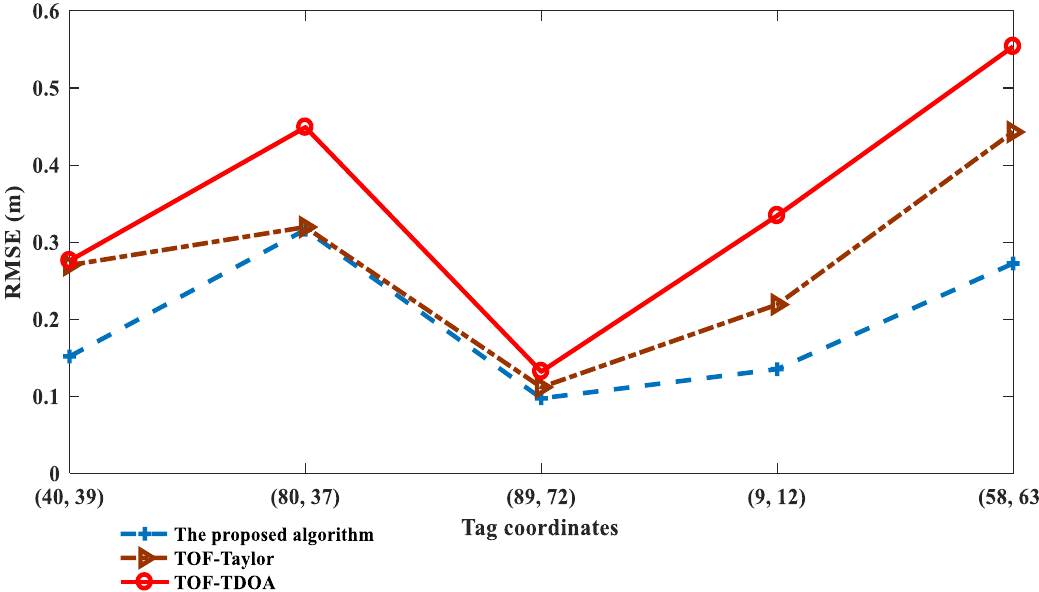
Figure 5. RMSE of the proposed positioning algorithm under different tag coordinates.